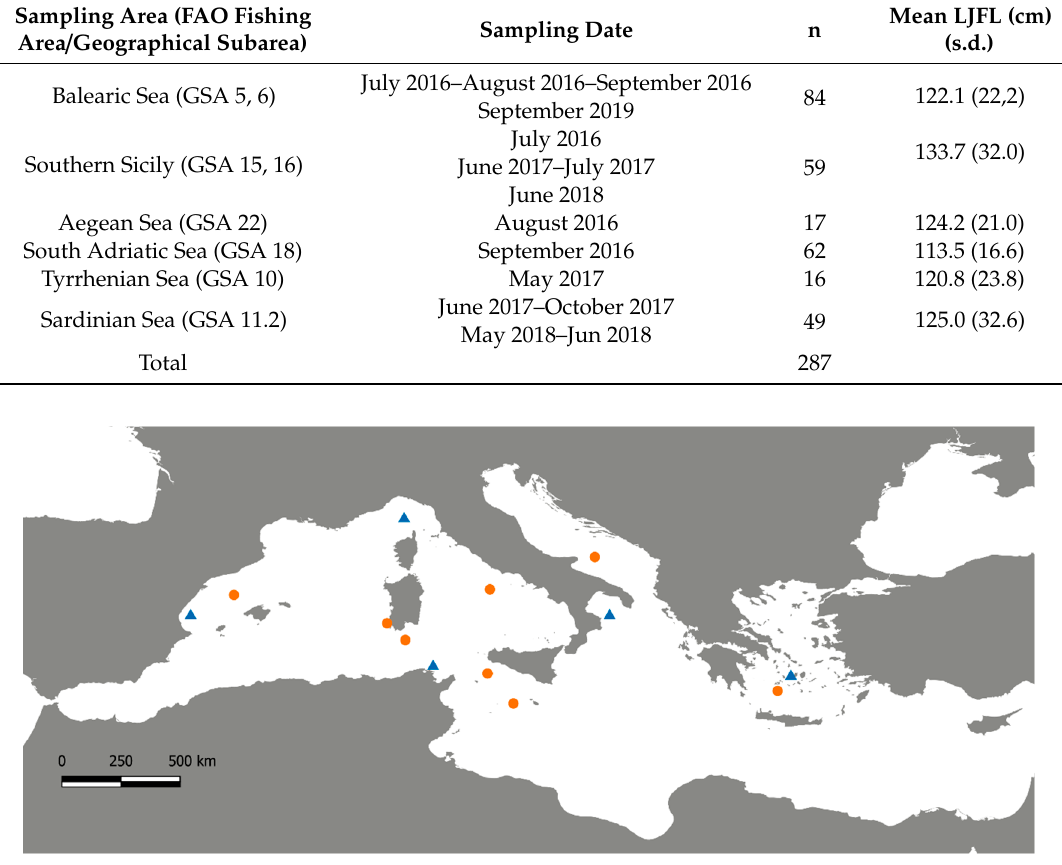
Table 1. Sampling details for swordfish analyzed in this study.